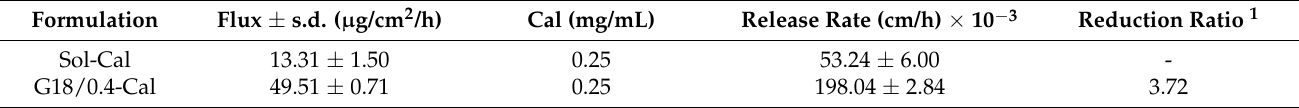
Table 3. Release parameters of Cal loaded in the indicated forms.